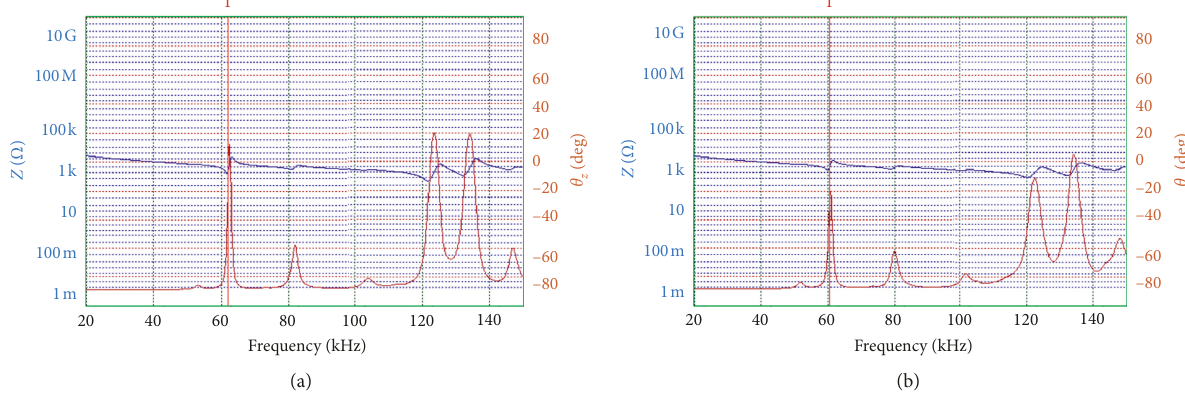
Figure 14: Results of impedance and phase angle spectra measurement of cylinder-type transducers: measurement of upper transducer, driving frequency is 82.1 kHz (a); measurement of lower transducer, driving frequency is 79.5kHz (b).